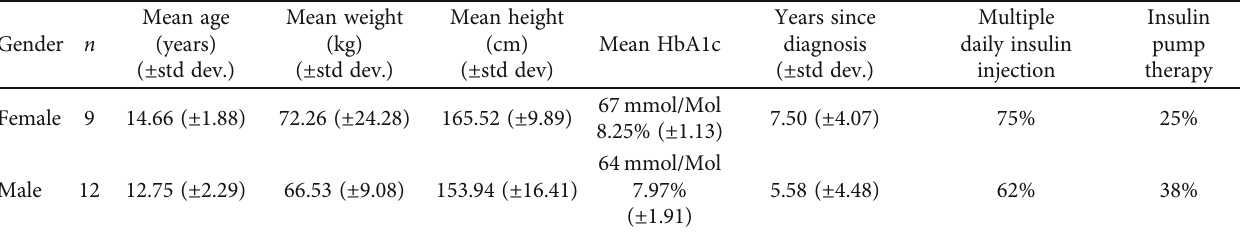
Table 1: Summary of participant age (years), HbA1c level (mmol/mol), time since diagnosis (years), and insulin regimen (% pump, % injection) ( mean ± std dev : ).